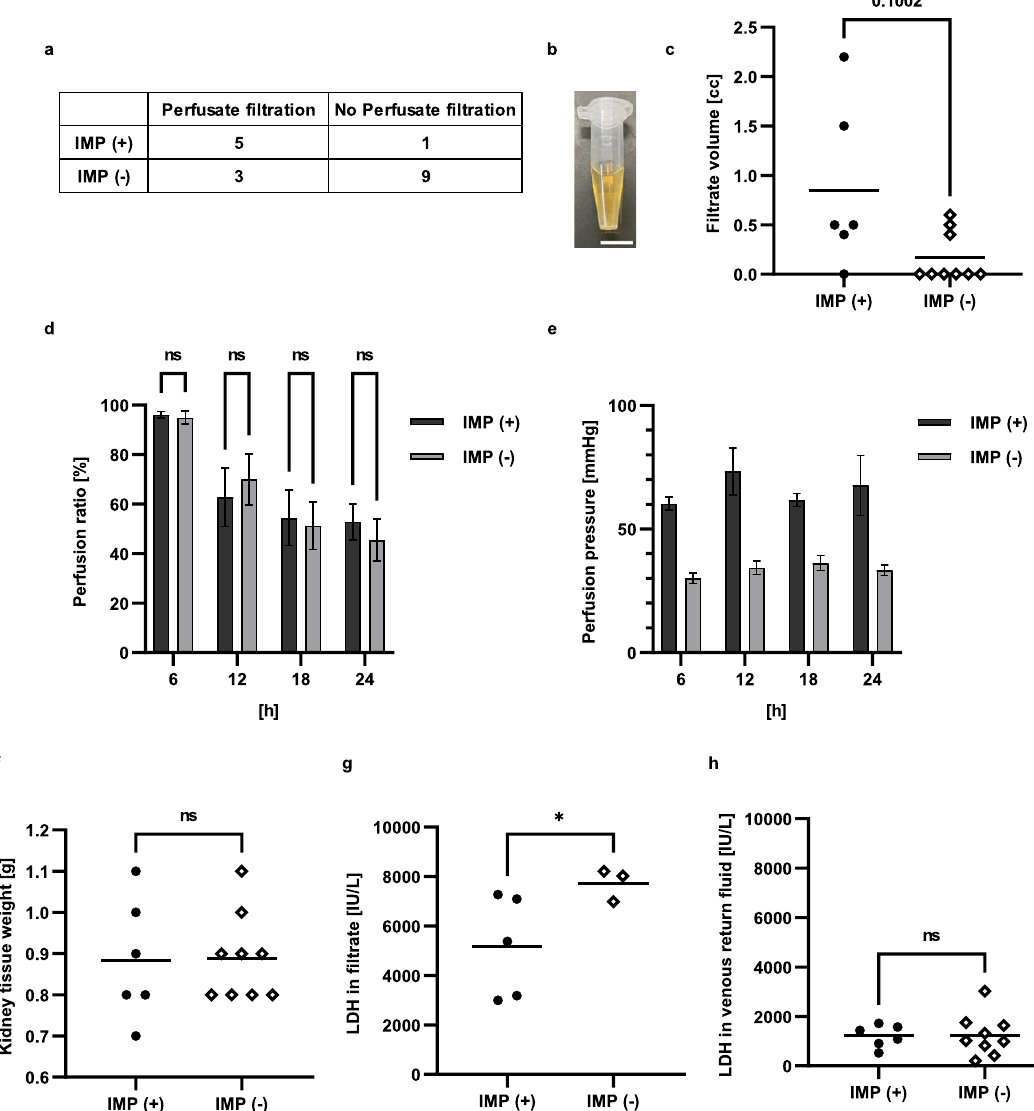
Figure 4. Effect of 24-h intermittent pressurization on kidney perfusion. ( a ) Filtrate breakdown in a total of 18 perfusion experiments. IMP (+) group: 6 cases, IMP (−) group: 12 cases. Fisher’s exact test: p < 0.05. ( b ) The 24-h filtrate collection. Scale bars: 1 cm. ( c ) Comparing filtrate output for 24 h of perfusion. IMP (+) group: 5 cases, IMP (−) group: 3 cases. P = 0.1002. ( d ) Kidney perfusion ratio was measured every 6 h for 24 h. The data are shown as means ± standard error of the mean. IMP (+) group: 6 cases, IMP (−) group: 12 cases. ( e ) The mean kidney perfusion pressure was measured every 6 h for 24 h. IMP (+) group: 6 cases, IMP (−) group: 12 cases. ( f ) The difference in kidney tissue weights before and after perfusion was measured. IMP (+) group: 6 cases, IMP (−) group: 9 cases. ( g ) LDH was analyzed for 24 h of filtrate collection. IMP (+) group: 5 cases, IMP (−) group: 3 cases. * p < 0.05. ( h ) LDH was analyzed for the perfusing solution leaving the venous outlet tube at 23–24 h. IMP (+) group: 6 cases, IMP (−) group: 9